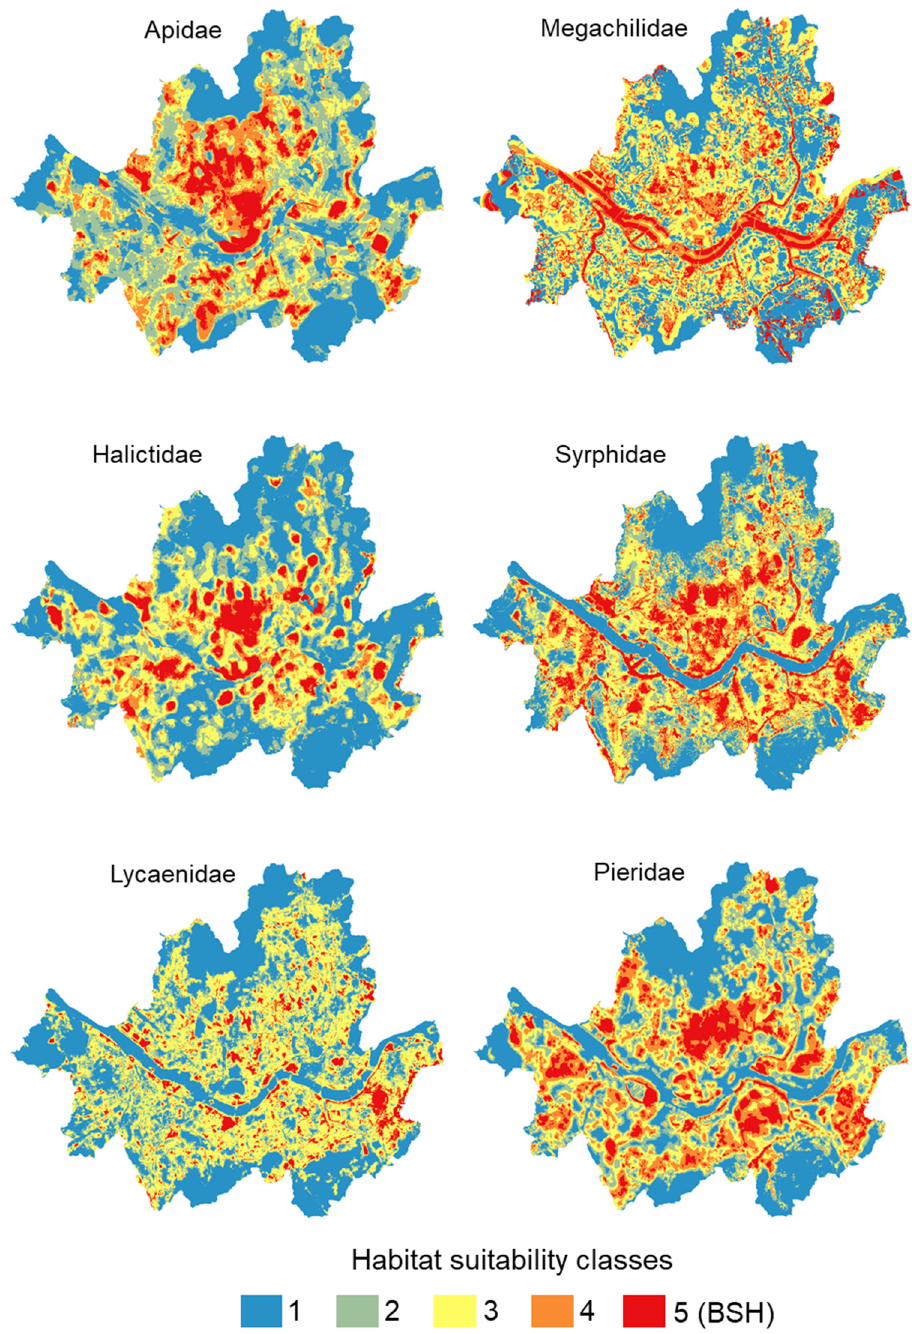
Figure 4. Estimated probability of observation of six families of pollinators in Seoul. For each family, the areas were ranked according to suitability classes ranging from 1 (blue areas, lowest probability of occurrence) to 5 (red areas, highest probability of occurrence, called in the manuscript “Best suitable habitats”, BSH).